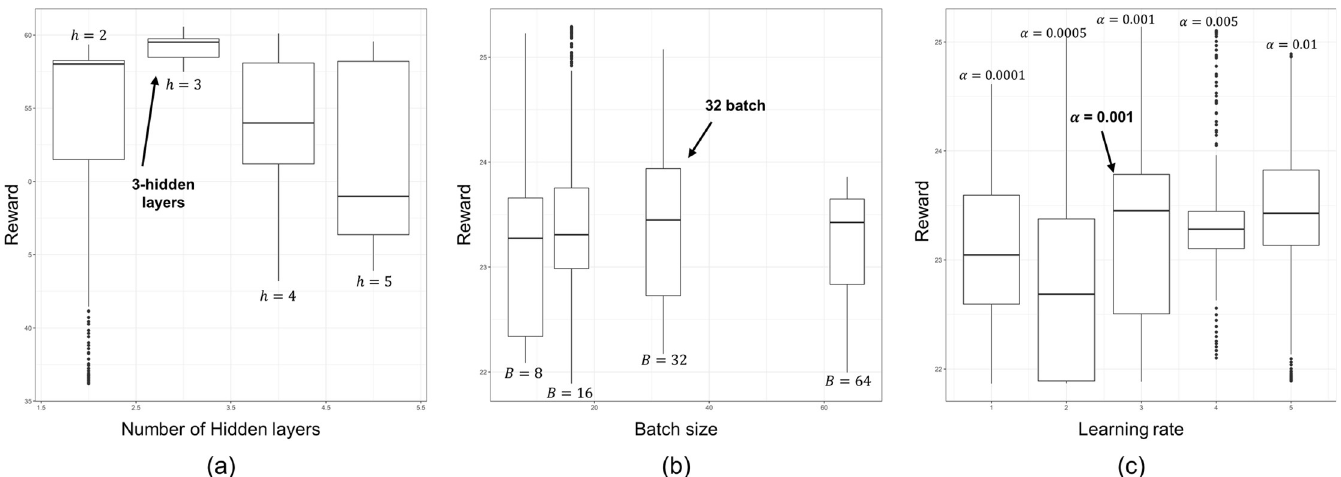
Fig 4. Training performances under different settings of hyper-parameters; (a) number of hidden layers; (b) size of replay buffer; (c) learning rate. (Drawn by authors using R program).